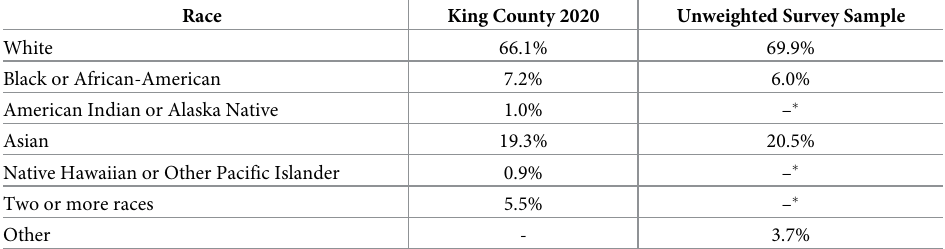
Table 3. Proportion of participants by race, King County, Washington anti-SARS-CoV-2 seroprevalence survey, August